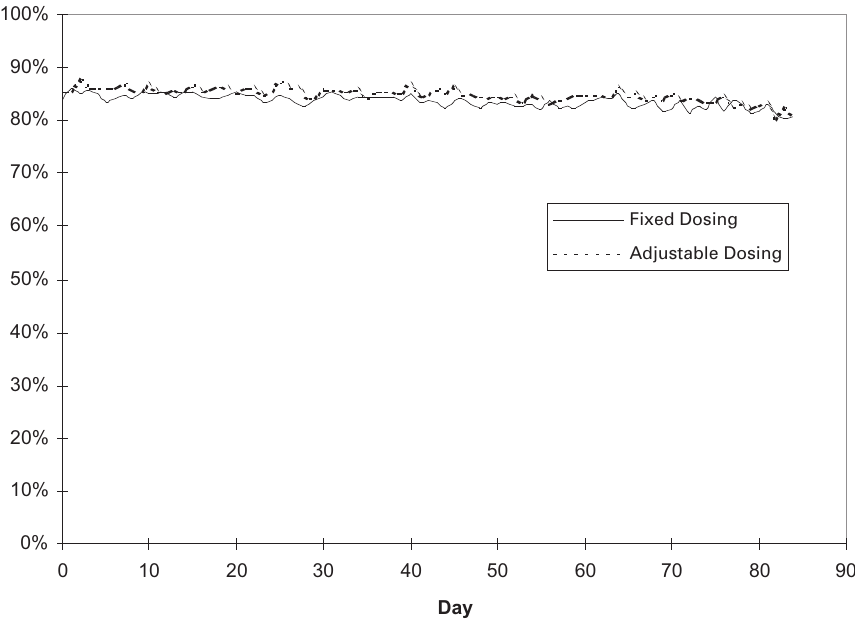
Figure 4 Morning peak flows in percentage of respective best of run-in between the 2 patient groups with fixed and adjustable